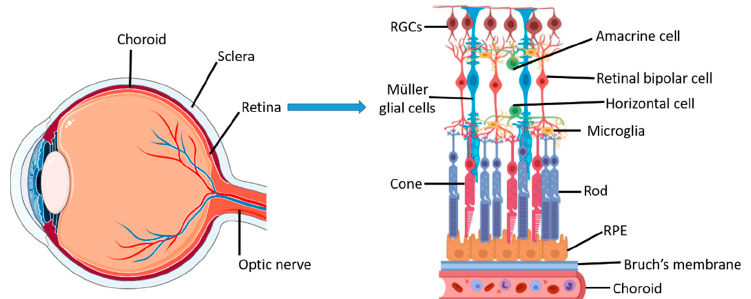
Figure 1. Representation of a cross-section of a human eye and a detail of the multilayer organization of the retina, Bruch’s membrane and choroid. The retinal layers include a retinal pigment epithelium (RPE), cone and rod photoreceptors, horizontal cells, bipolar cells, amacrine cells, microglia and Müller glial cells and ganglion cells (RGCs).